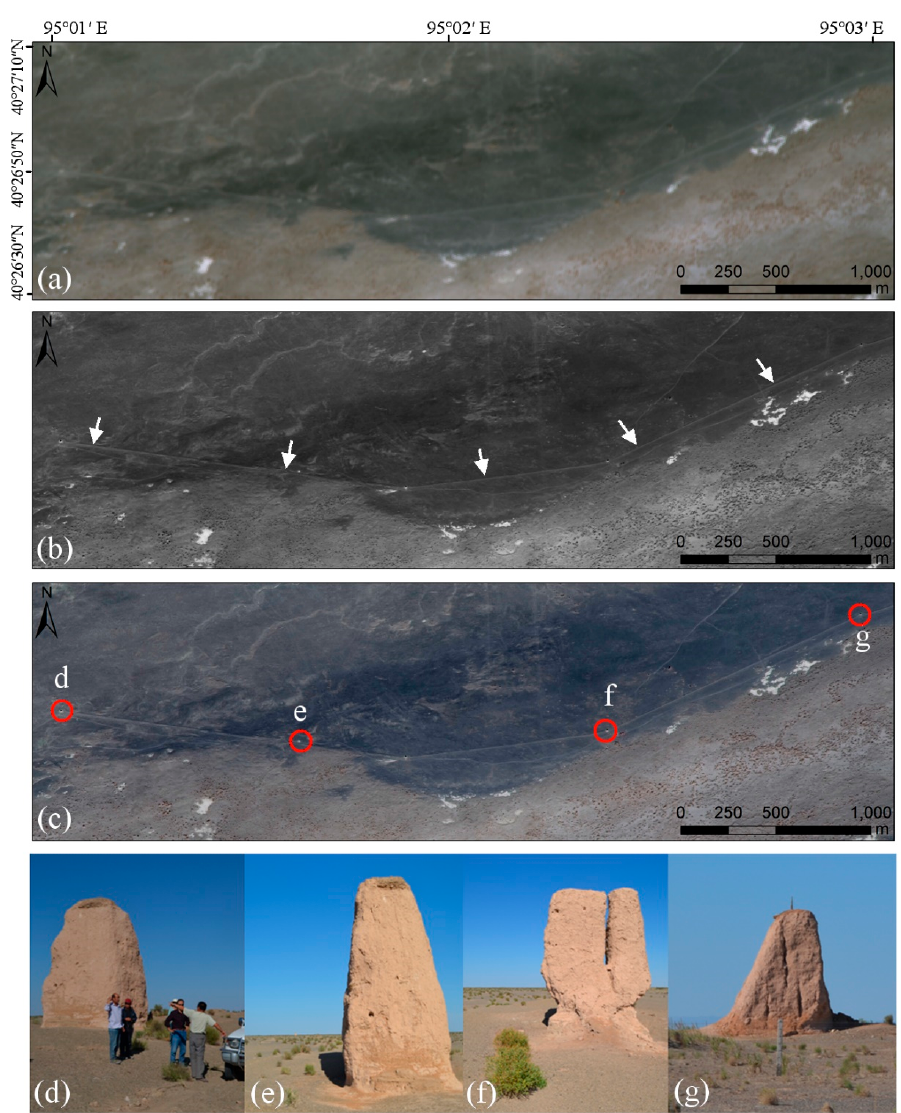
Figure 5. Gaofen-1 (GF-1) multispectral (MS) image (RGB432) ( a ) and panchromatic (PAN) image ( b ) of the linear traces of GH in Dunhuang. ( c ) 2 m GF-1 PMS pansharpened data (RGB432); the white arrows in ( b ) indicate the linear traces and the red circles in ( c ) represent the remaining beacon towers ( d – g ).